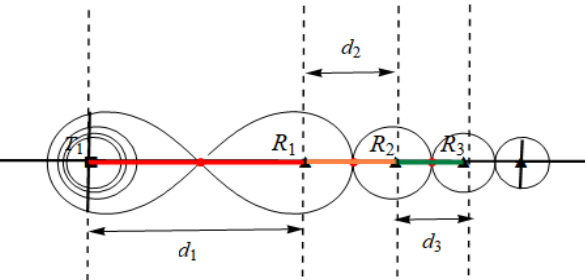
Figure 5. The maximum placement spacing sequence in internal coverage area of sequence T − R n . (The length of the red line segment is d 1 , the length of the yellow line segment is d 2 , and the length of the green line segment is d 3 .).